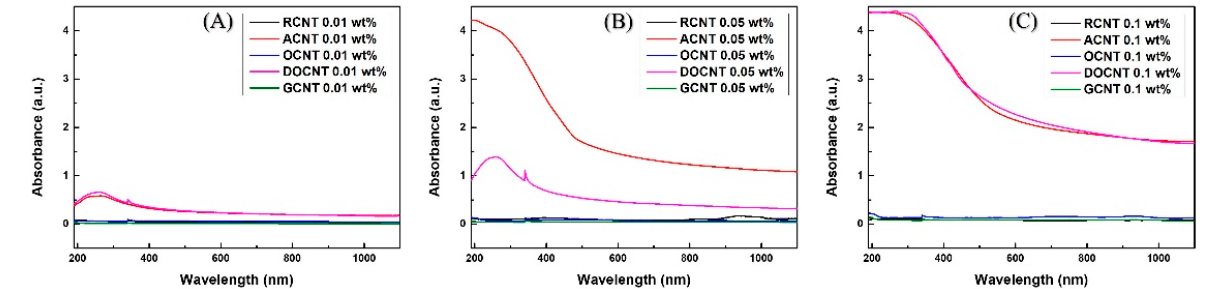
Figure 7. UV–Vis spectra measurement for the dispersion of MWCNT nanofluids by concentration at ( A ) 0.01, ( B ) 0.05, and ( C ) 0.1 wt%.